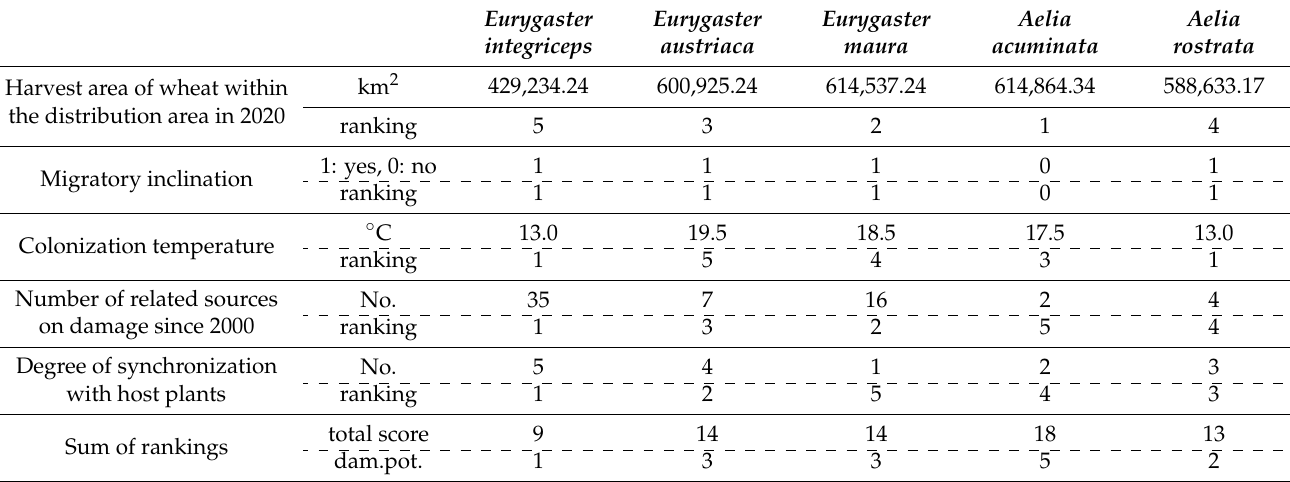
Table 1. Ranking of cereal bugs according to their damage